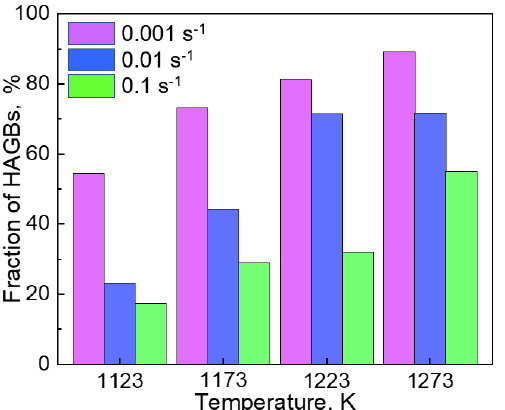
Figure 8. The length fraction of high angle grain boundaries (HAGBs) in the samples hot-compressed at 1123, 1173, 1223, and 1273 K with strain rates of 0.001, 0.01, and 0.1 s −1 .